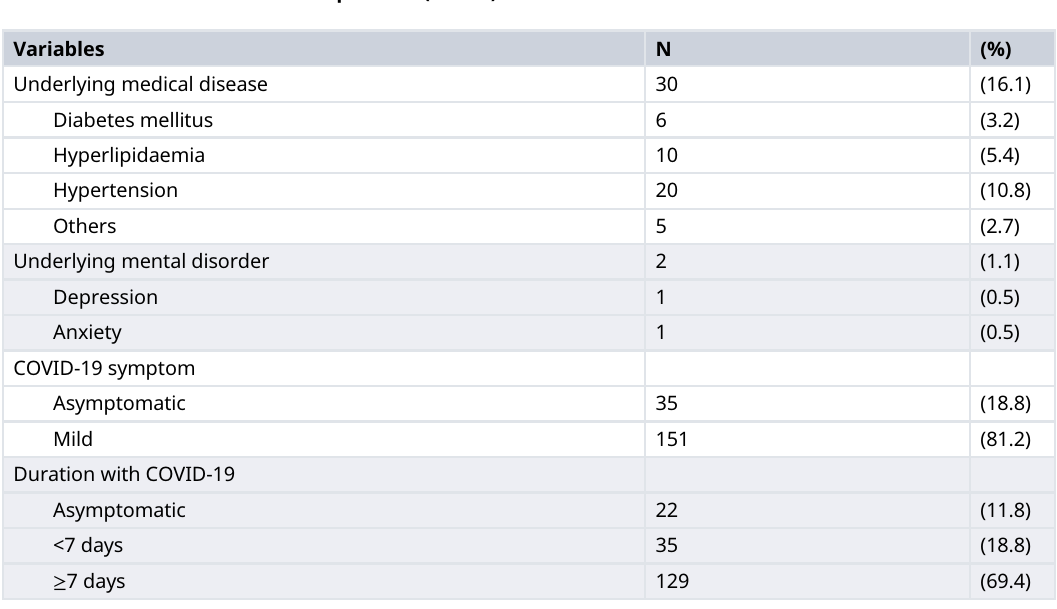
Table 2. Clinical characteristics of patients